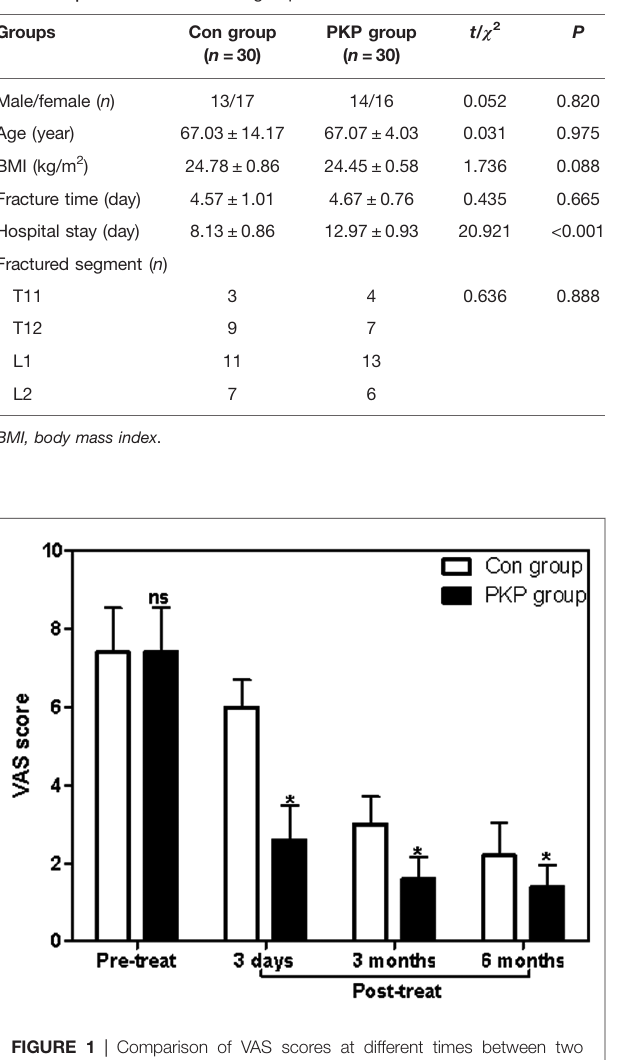
TABLE 1 | Baseline data in two groups.